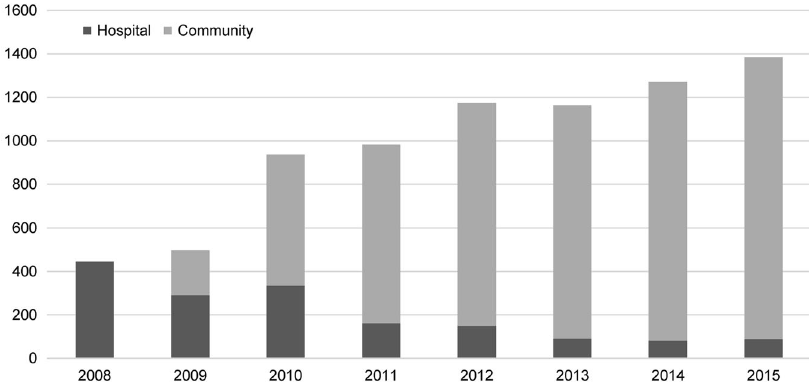
Fig. 1 Changes in number and location of assessment of patients with sleep disordered breathing